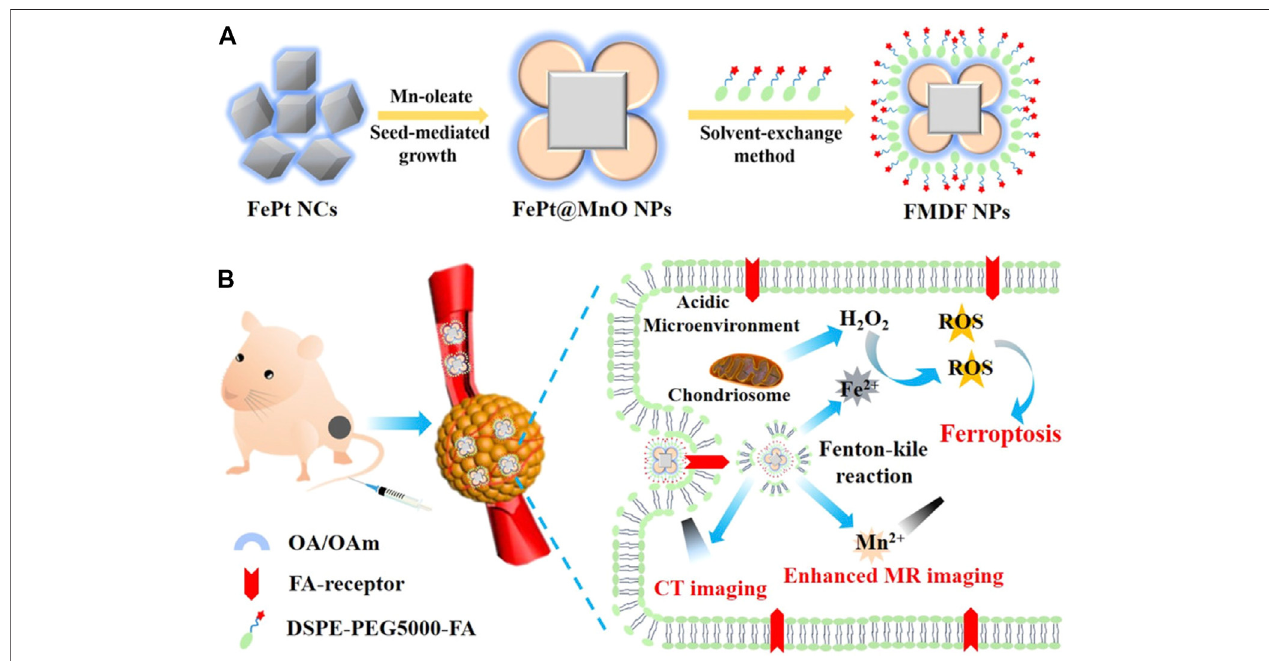
FIGURE 7 | (A) Synthesis scheme of FMDF NPs. (B) Acidic-responsive and dual-model imaging-guided FBT/CDT. Adapted from Yang et al., (2019) Copyright @ 2019 (ACS).